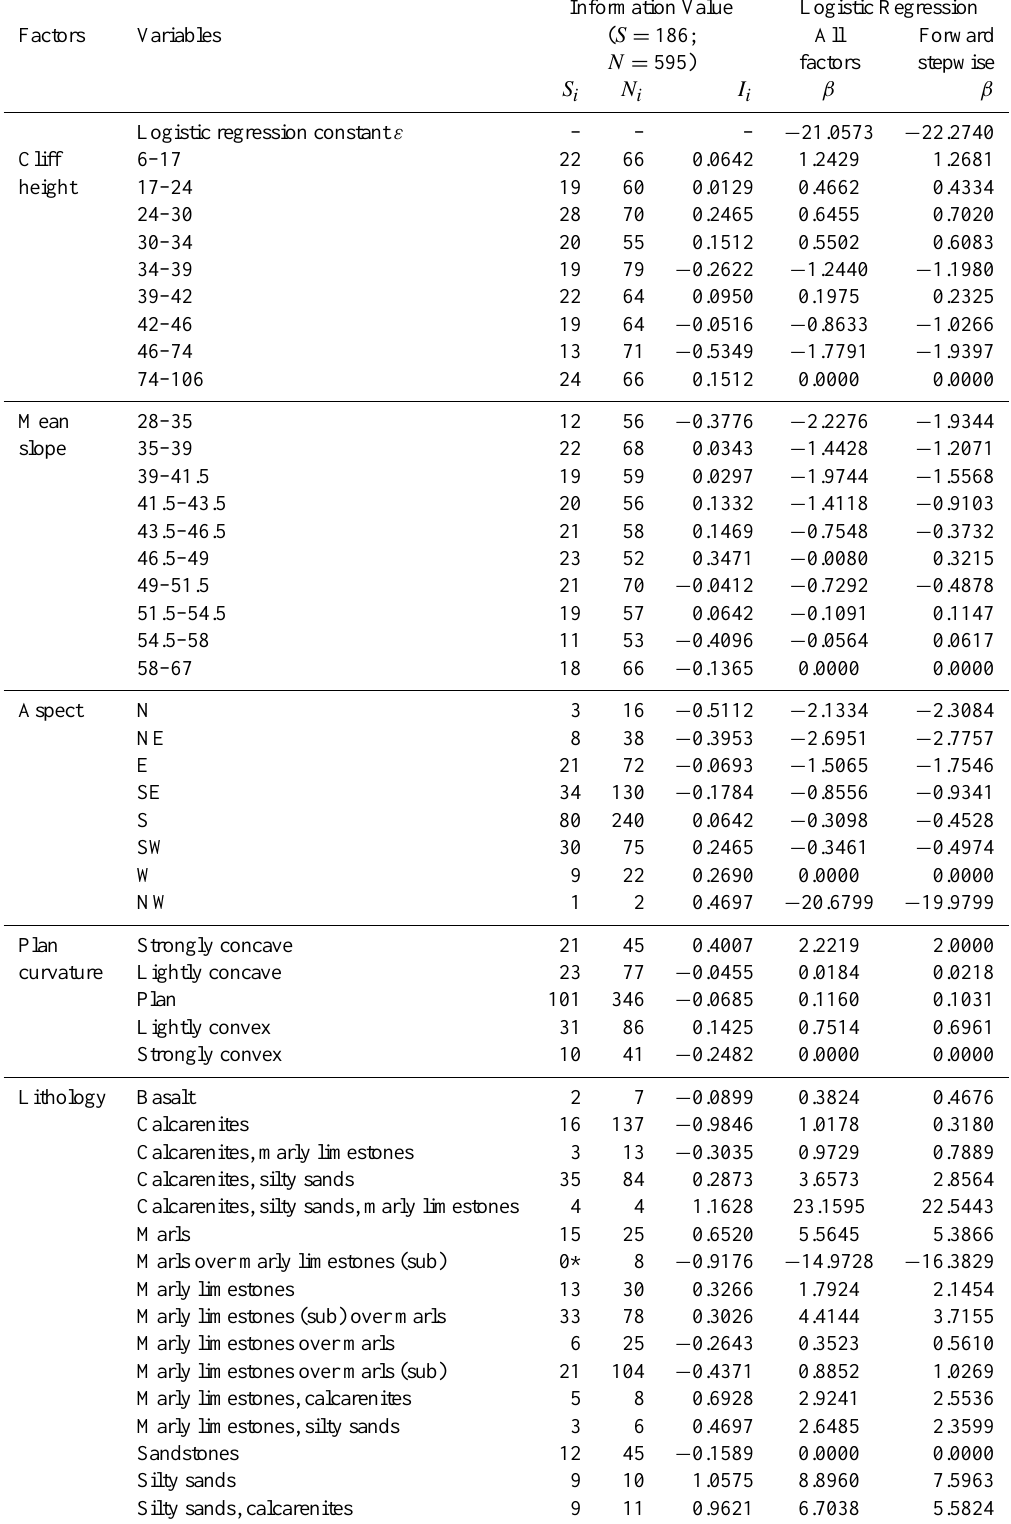
Table 2. Information Value ( I i ) and Logistic Regression (Constant, B values)